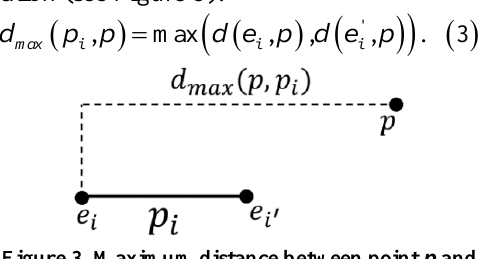
Figure 3. Maximum distance between point p and uncertain point p . i